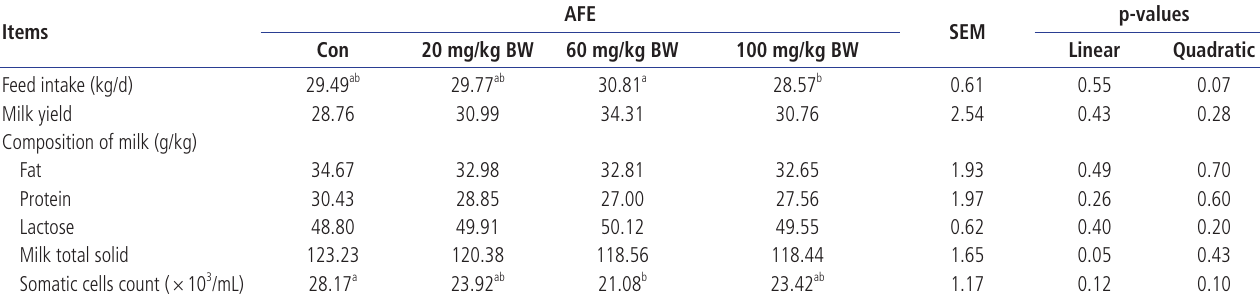
Table 3. Effects of AFE on production performance of dairy cows